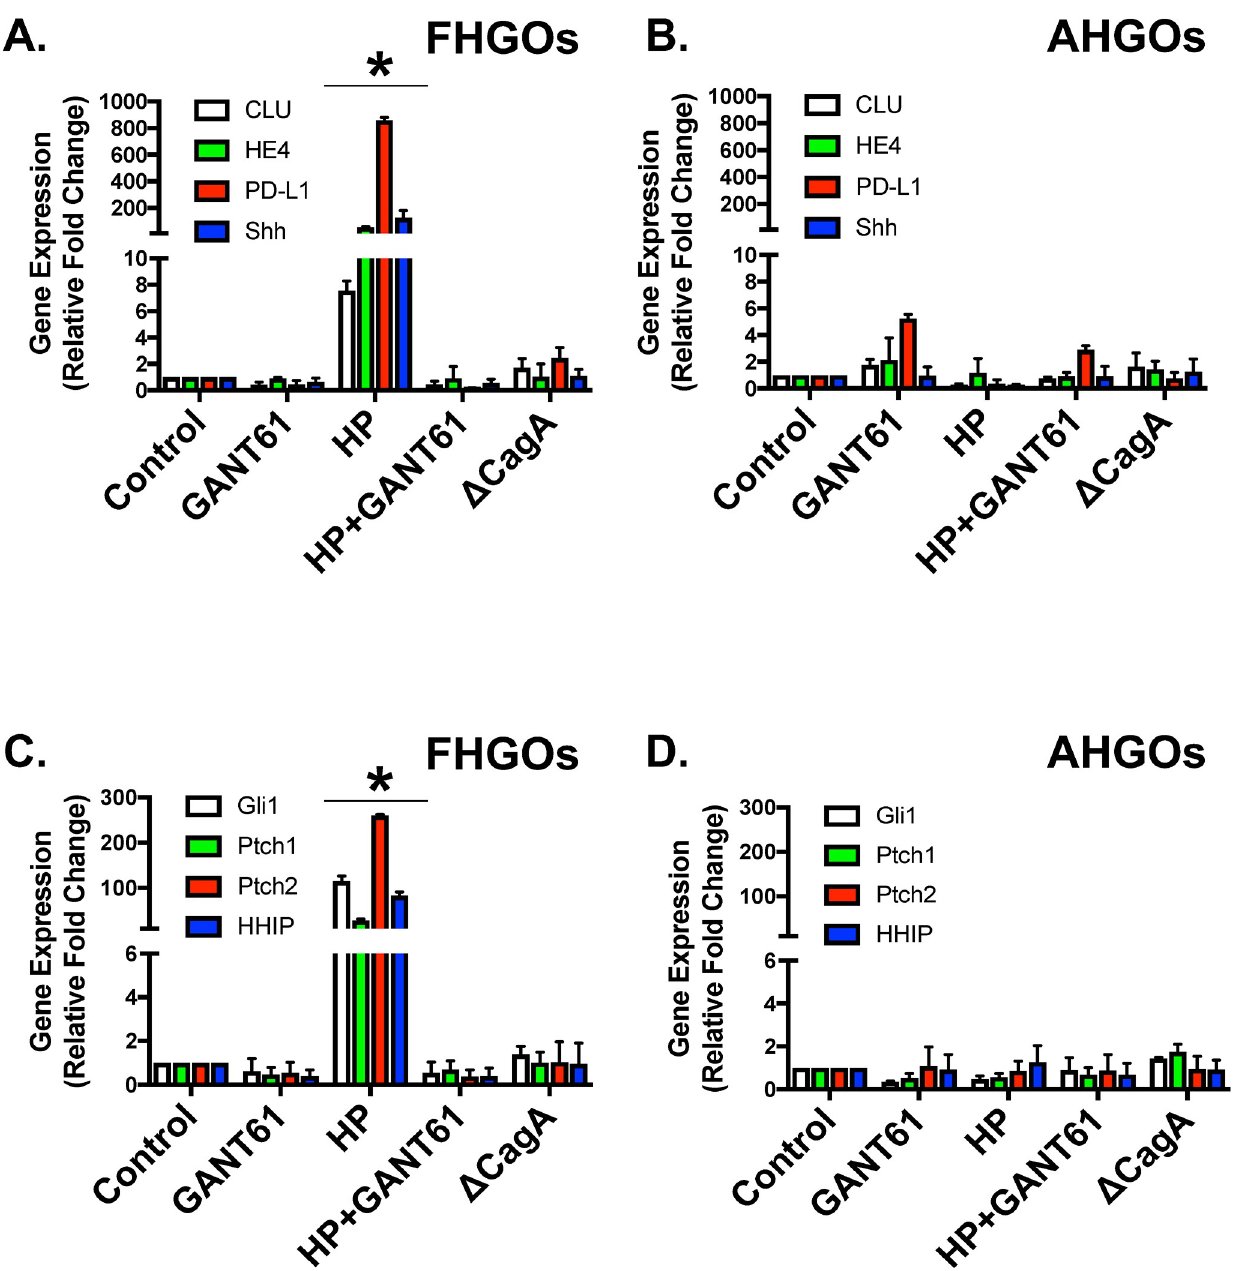
Fig 6. Changes in PD-L1, Hedgehog signaling and markers of SPEM in FHGOs and AHGOs infected with H . pylori . Quantitative RT-PCR analysis for the expression of PD-L1, Shh and SPEM markers clusterin (CLU) and human epididymis 4 (HE4) performed using RNA collected from each experimental group of the (A) FHGOs and (B) AHGOs. Quantitative RT-PCR analysis for the expression of canonical Hedgehog signaling genes Gli1, Ptch 1, Ptch 2 and Hedgehog Interacting Protein (HHIP) was performed using RNA collected from each experimental group of the (C) FHGOs and (D) AHGOs. � P < 0.05 compared to control group by two-way ANOVA, n = 3 individual organoid